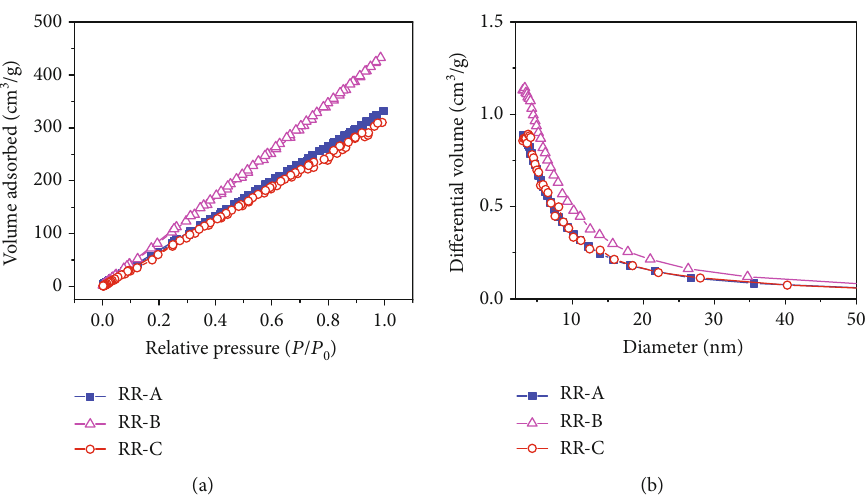
Figure 2: (a) Nitrogen adsorption/desorption isotherms. (b) Pore size distribution calculated from desorption isotherm using the BJH method. Table 2: Multipoint BET summary for raw sample (RR-A), calcined (RR-B), and utilized sample (RR-C).